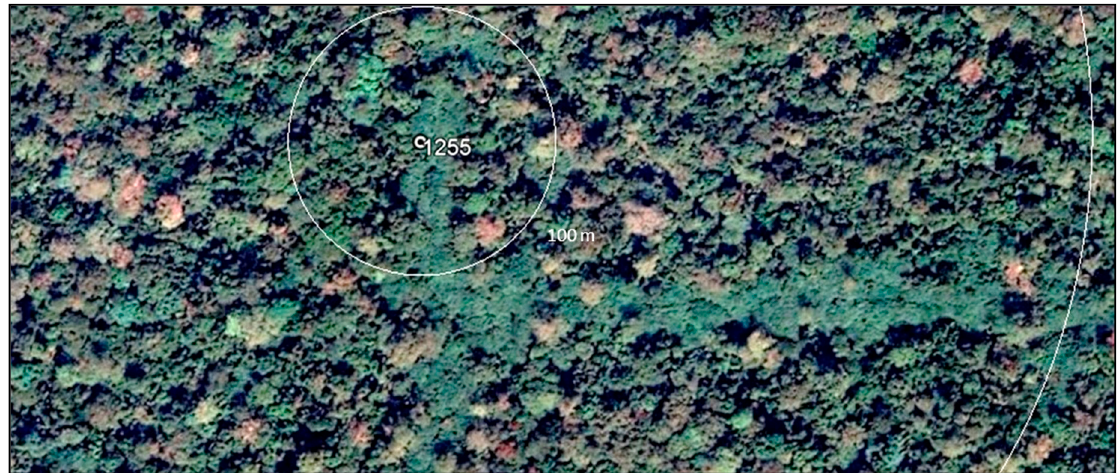
Figure 10. Point 1255 in closer detail. The abandoned and regrown logging road are clearly visible in high resolution satellite imagery (1 ◦ 53 (cid:48) 47.77” N, 21 ◦ 58 (cid:48) 36.09” E).